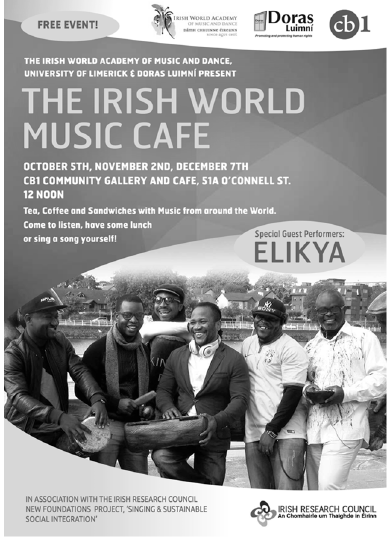
Figure 4. The Irish World Music Café (Poster Design by Joe Gervin).